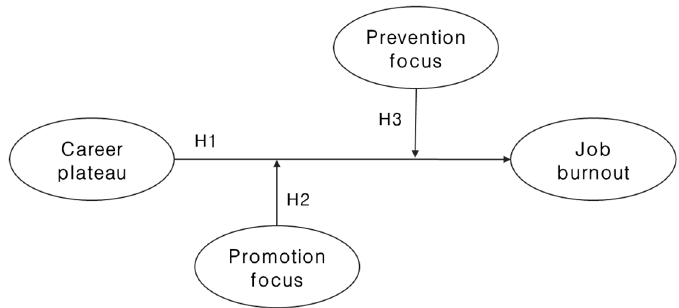
Figure 1. Research